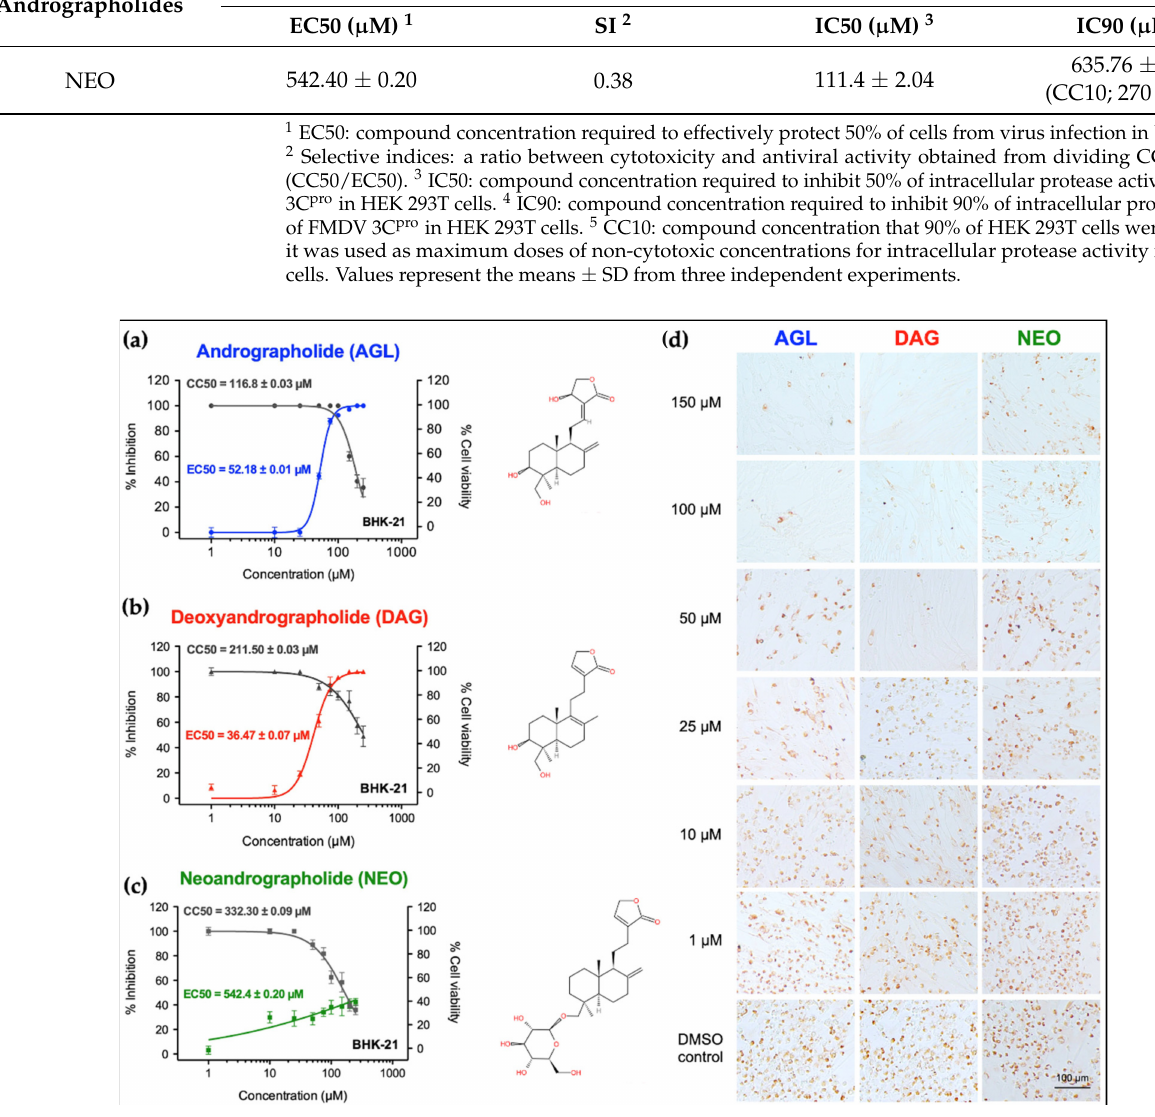
Figure 1. Antiviral activities of AGL, DAG, and NEO against FMDV in BHK-21 cells. ( a – c ) Cytotoxic- ity in BHK-21 cells and FMDV inhibitions by dose-dependent manners were carried out using MTS assay (dark grey) and IPMA (blue for AGL, red for DAG and green for NEO, respectively); ( d ) An- tiviral activities of andrographolides were conducted by the presence of the positive FMDV-infected BHK-21 cells in various concentrations compared to that of cell controls with 0.01% DMSO. The data are presented as means and SD from three independent